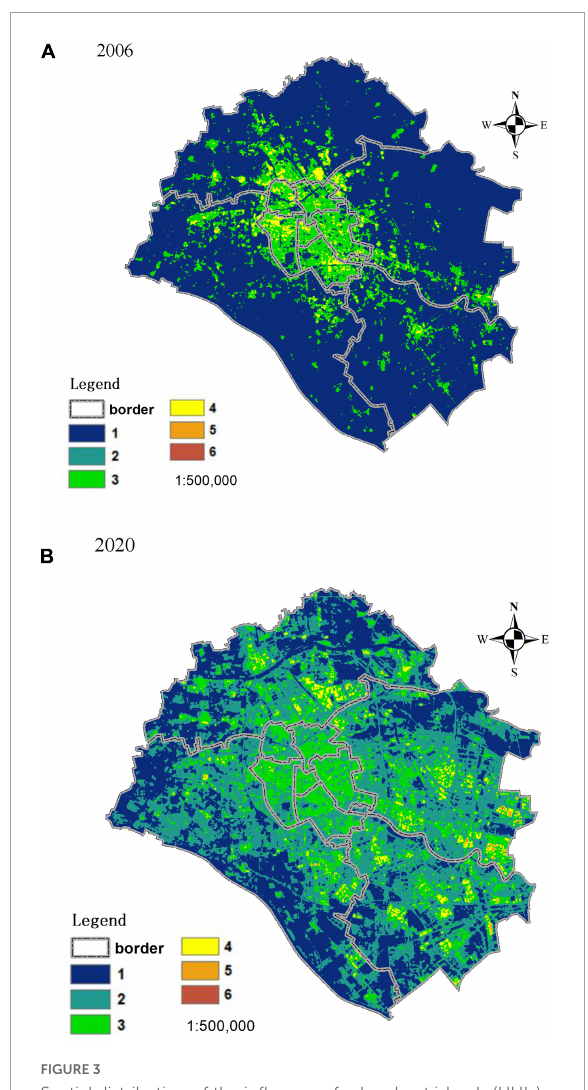
FIGURE3 Spatial distribution of the influence of urban heat islands (UHIs) on health in (A) 2006 and (B) 2020.